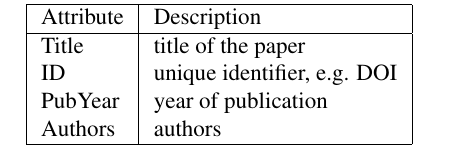
Table 2. Defined relevant metadata attributes for additional paper, which introduces the benchmark and, in particular, evaluation results.